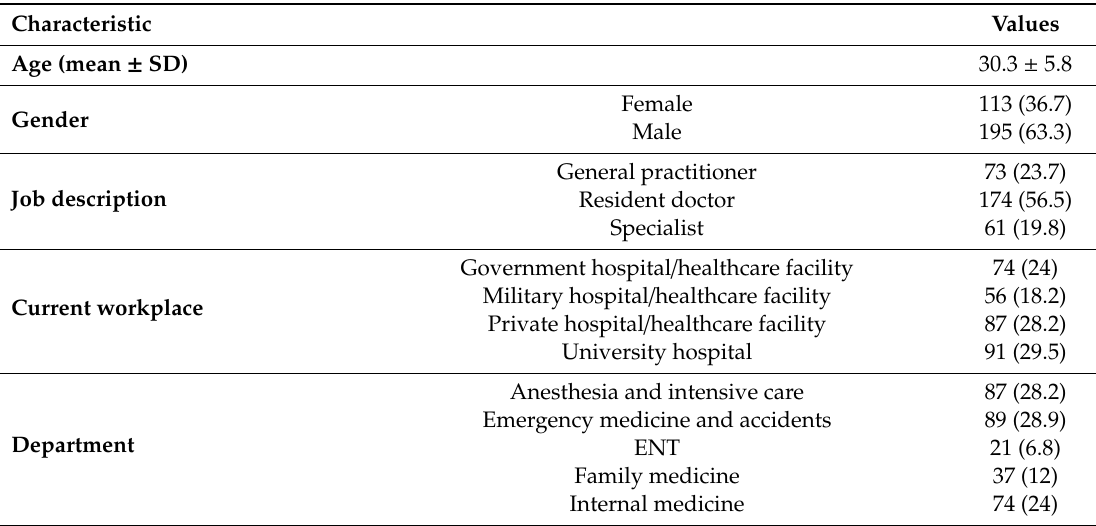
Table 1. Demographics, awareness about COVID-19 (Coronavirus Disease of 2019) infection control practices, and adherence of frontline Jordanian doctors to common safety measures during COVID-19